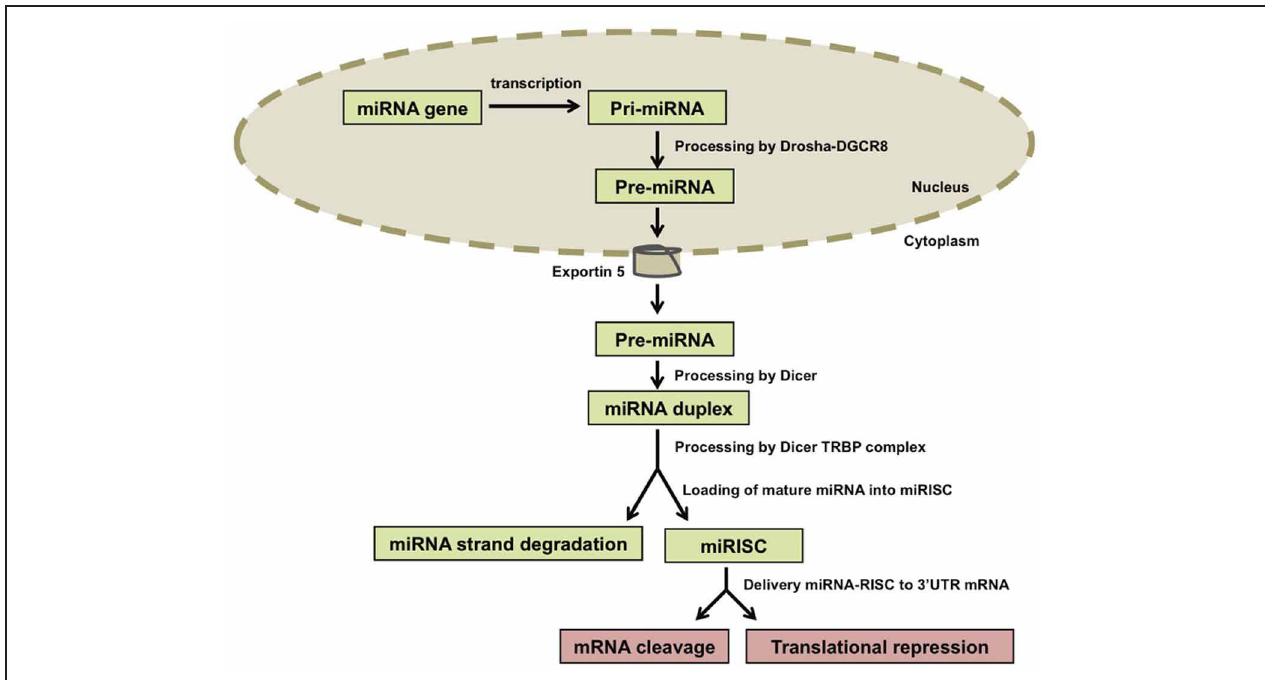
FIGURE 1 | Biogenesis of microRNAs (miRNAs). miRNA genes are transcribed and the resulting primary transcripts (pri-miRNAs) are polyadenylated at the 3 (cid:3) end and capped at the 5 (cid:3) end. Pri-miRNA molecules are recognized by the Drosha-DGCR8 complex and trimmed in a precursor-miRNA (pre-miRNA) that is transported to the cytoplasm by Exportin-5. In the cytoplasm, Dicer processes the pre-miRNAs and one